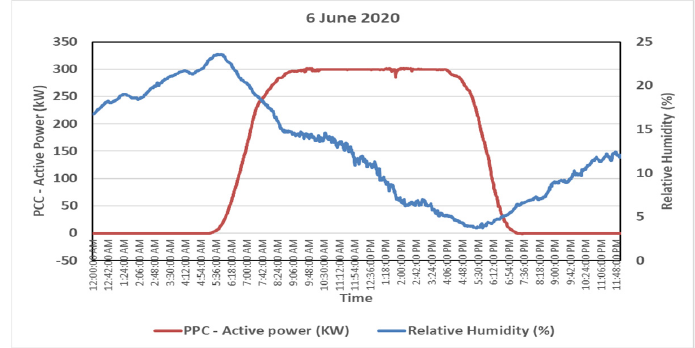
Figure 20. Active power vs. relative humidity on a least humid day.